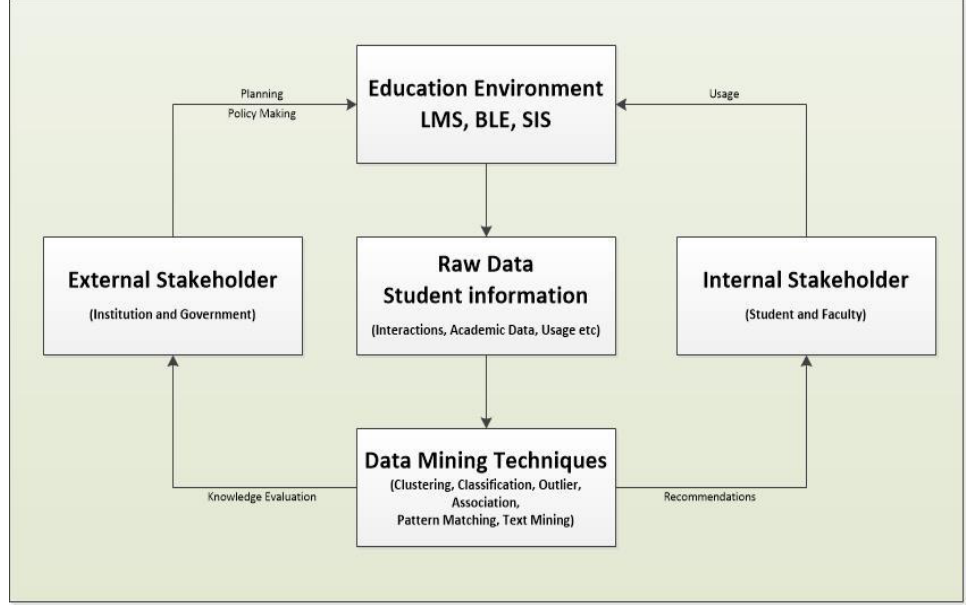
Figure 2. The cycle of applying data mining in education [31].